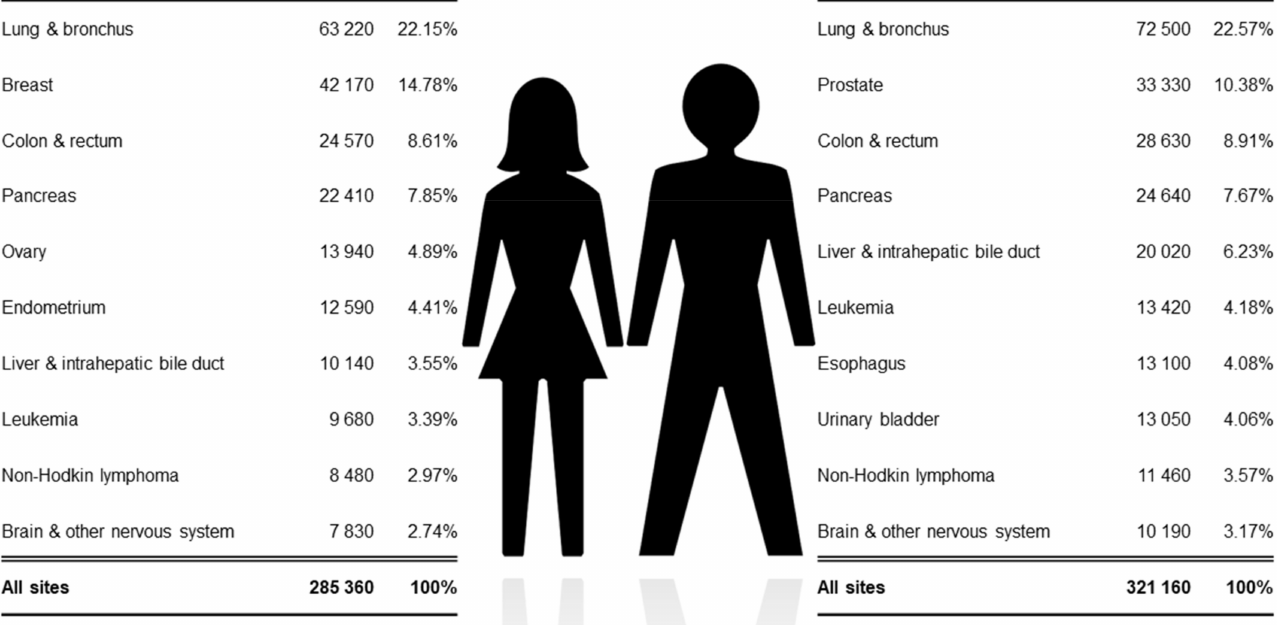
Figure 1. Estimated deaths in the USA in 2020 by cancer type and gender. Source: SEER